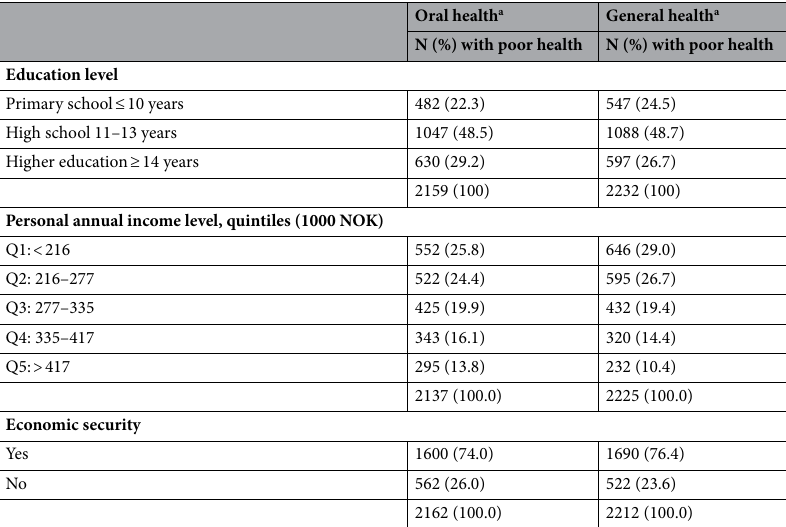
Table 2. Distribution of self-reported “poor general health” and “poor oral health” by level of education, personal income and economic security. a ‘Poor’ is defined as those who self-reported general health or oral health as fair, poor and very poor.